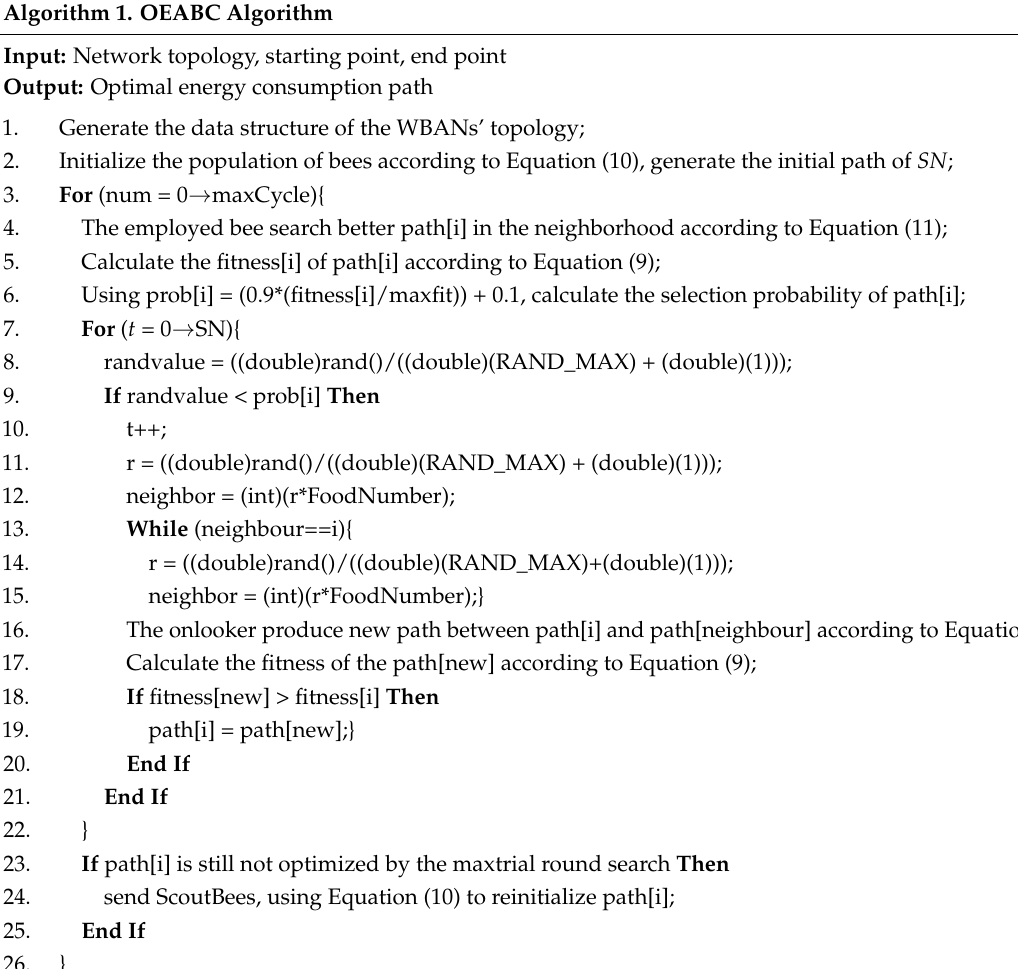
Algorithm 1. OEABC